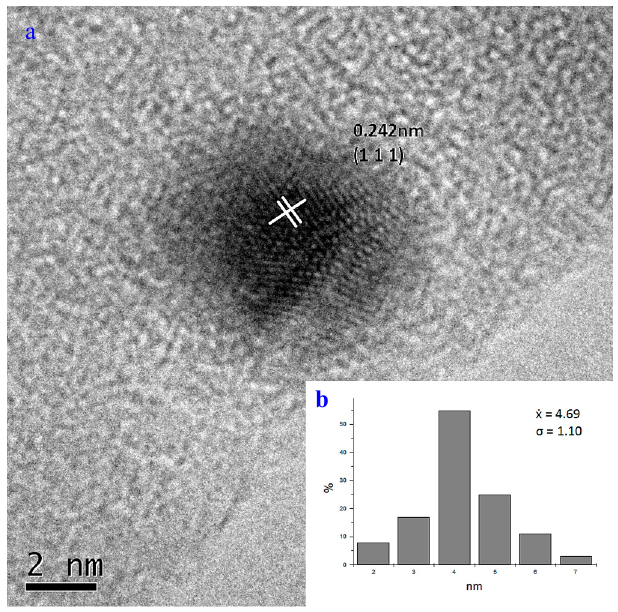
Figure 2. ( a1–a5 ) Mean and standard deviation by group: GI, GII, GIII, GIV and GV; ( b1–b5 )